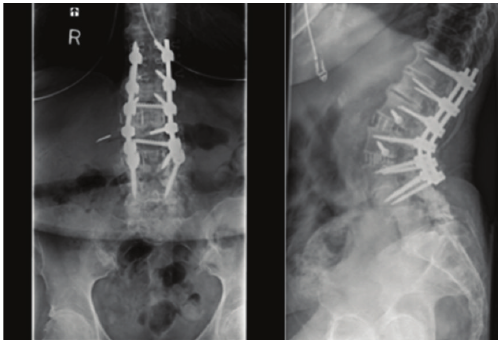
Figure 4: AP and lateral radiographs of the lumbosacral spine showing interbody fusion at L1-L2, and L2-L3 via the lateral approach and extension of posterior instrumentation and fusion from T11-L4. Notice improvement of lumbar lordosis and height restoration at the neuroforamina of